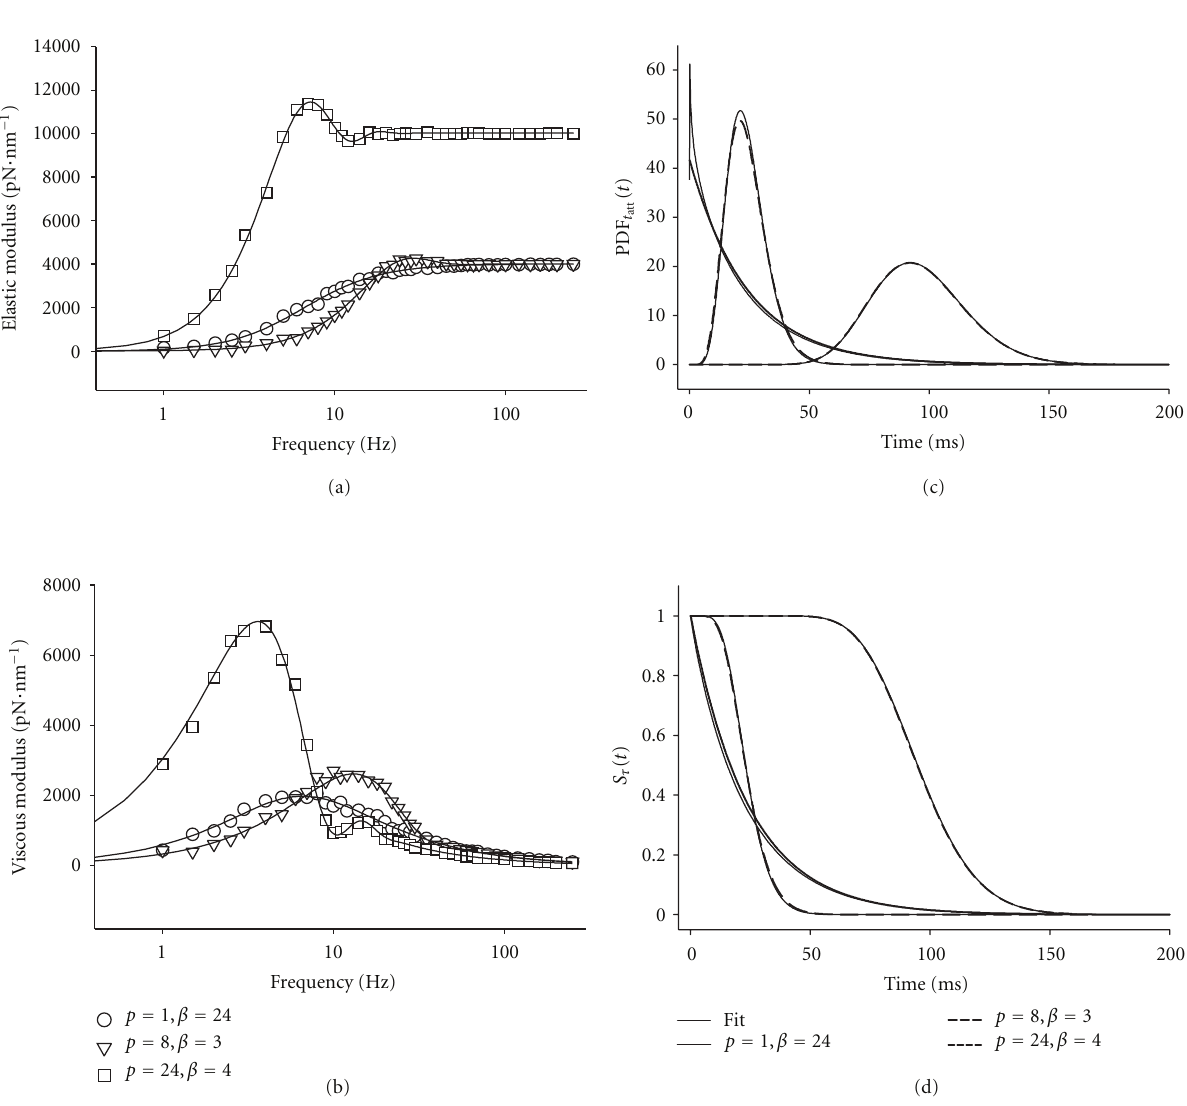
( t ) used to generate the data and the gamma att ( t att